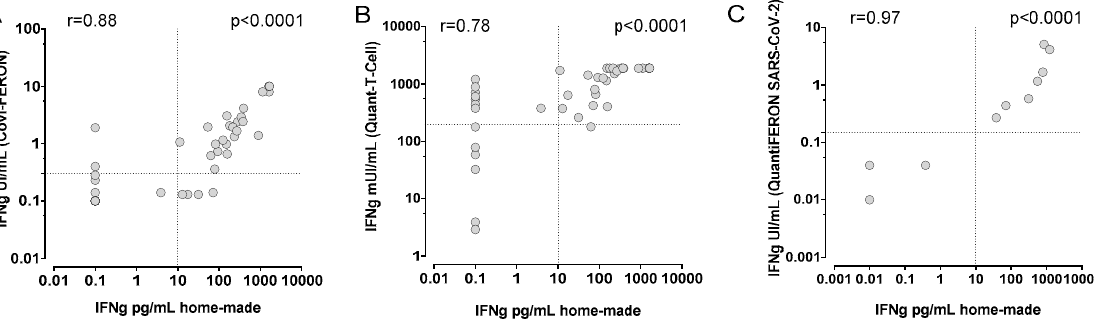
Figure 3. Comparison of home-made WB stimulation assay with Covi-FERON ( A ), Quant-T-Cell ( B ) and QuantiFERON SARS-CoV-2 ( C ) tests. Correlation was determined using Spearman correlation test and r and p value were given for each comparison.